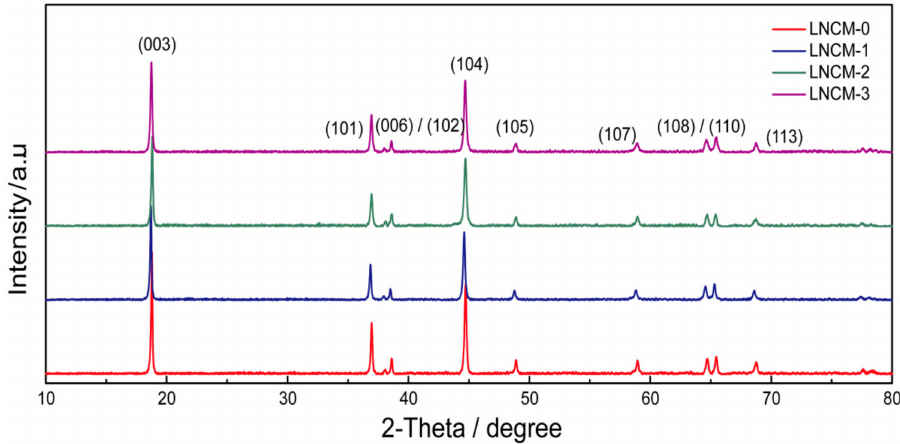
Figure 1. XRD patterns of as-prepared LiNi 1 / 3 Co 1 / 3 Mn 1 / 3 O 2